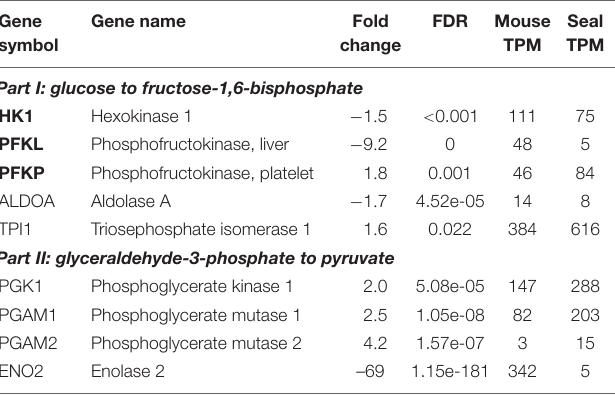
TABLE 3 | Expression of genes involved in glycolysis in the mouse and hooded seal cortical neurons.